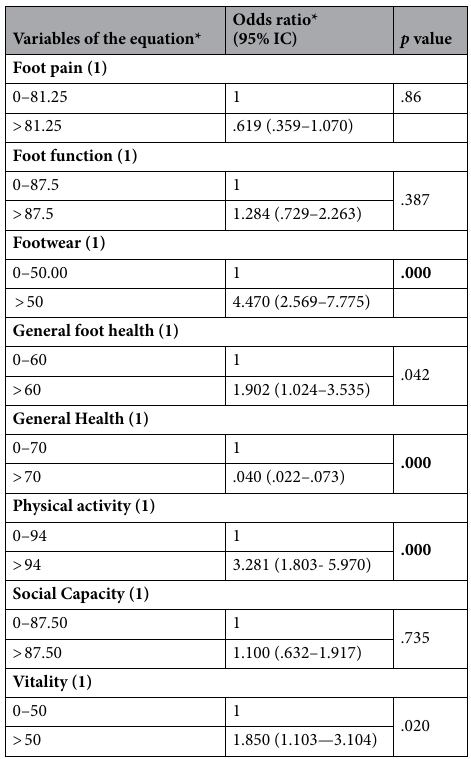
Table 3. Factors that affect the presence of pathologies in the feet according to the items of the scale used. *Adjusted Odds Ratio by sex, age and BMI. (1) Poor Health Status. *The median value has been used for the cut off